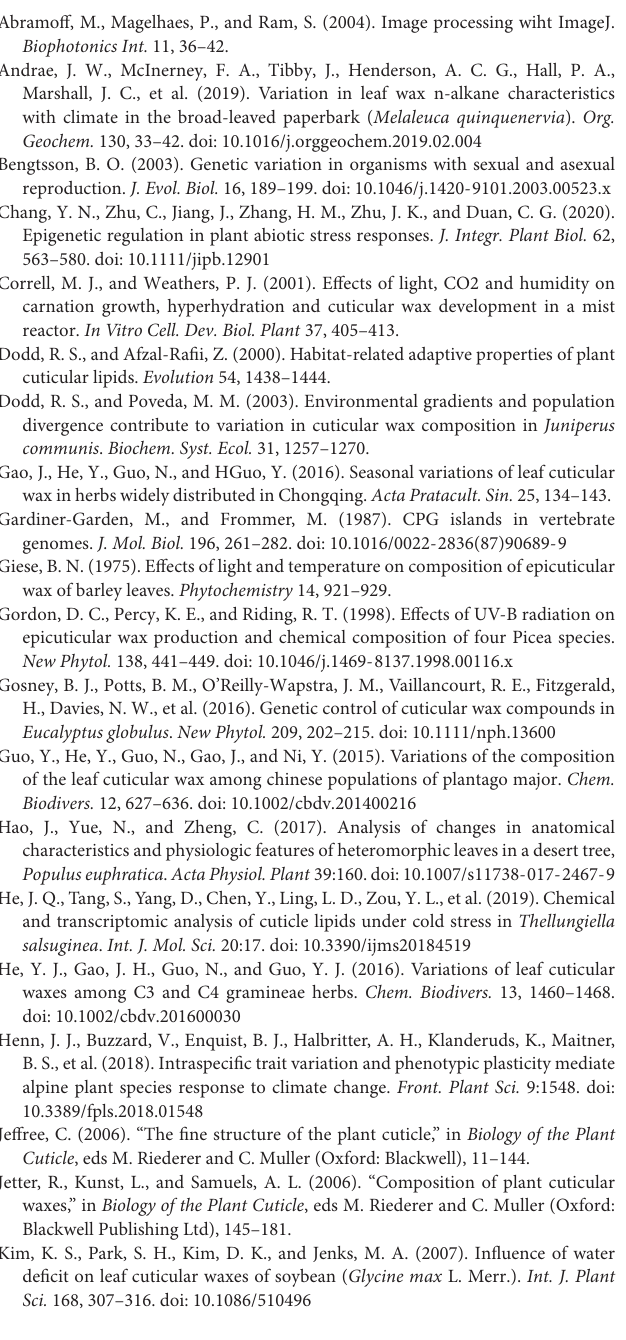
Supplementary Table 3 | Correlation analysis of original environmental factors with seed and leaf characters. Supplementary Table 4 | Primers used in this